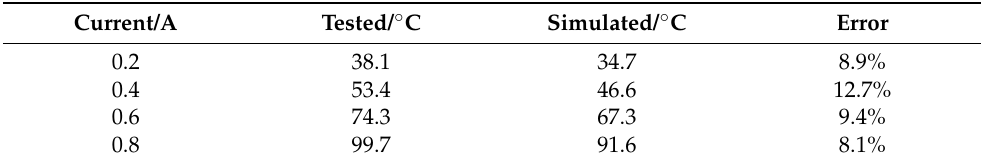
Figure 19. Comparison between experimental value and simulation value. Table 4. Comparison of experimental and simulated values under different currents (maximum temperature).